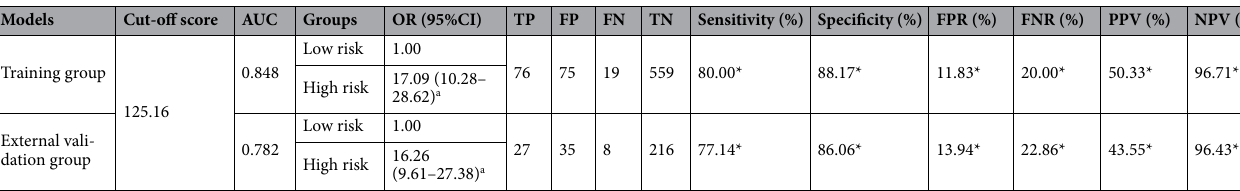
Table 3. Association between total risk scores and risks of PTB at < 32 weeks. TP true positive, FP false positive, FN false negative, TN true negative, FPR false positive rate (= 1-specificity), FNR false negative rate (= 1-sensitivity), PPV positive predictive value, NPV negative predictive value. a Adjustment for age, smoking,